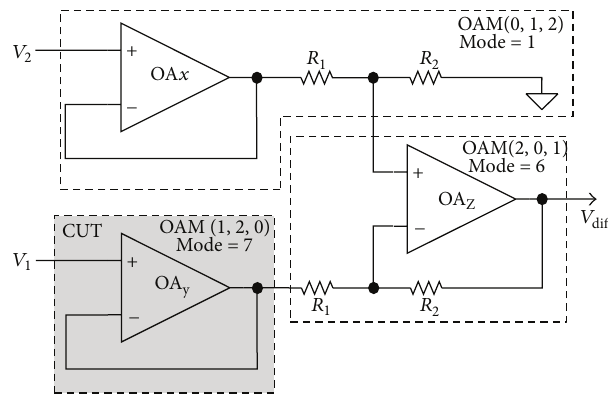
Figure 10: Three-OA differential amplifier